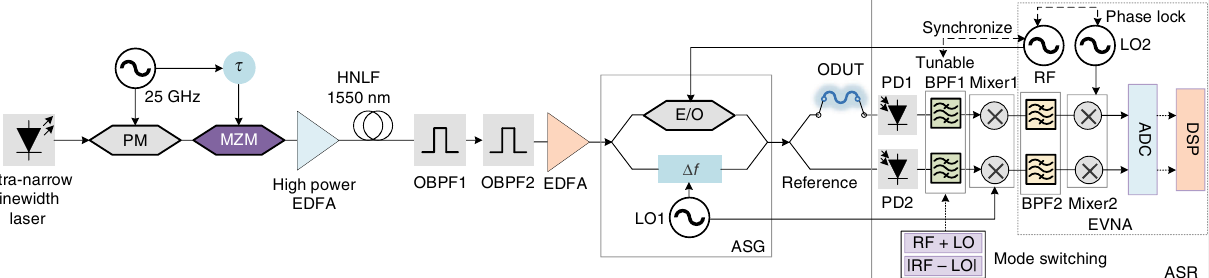
Fig. 2 Experimental setup of the proposed OVA. ASG and ASR are used for measurement of magnitude and phase response, and the OFC for measurement range expansion. PM, phase modulator; MZM, Mach-Zehnder modulator; OBPF, optical bandpass fi lter; EDFA, erbium-doped fi ber ampli fi er; HNLF, highly nonlinear fi ber; ASG, asymmetric optical probe signal generator; RF, radio frequency; LO, local oscillator; E/O, electro-optic; ODUT, optical device under test; ASR, asymmetric optical probe signal receiver; PD, photodetector; BPF, optical bandpass fi lter; ADC, analog-to-digital converter; DSP, digital